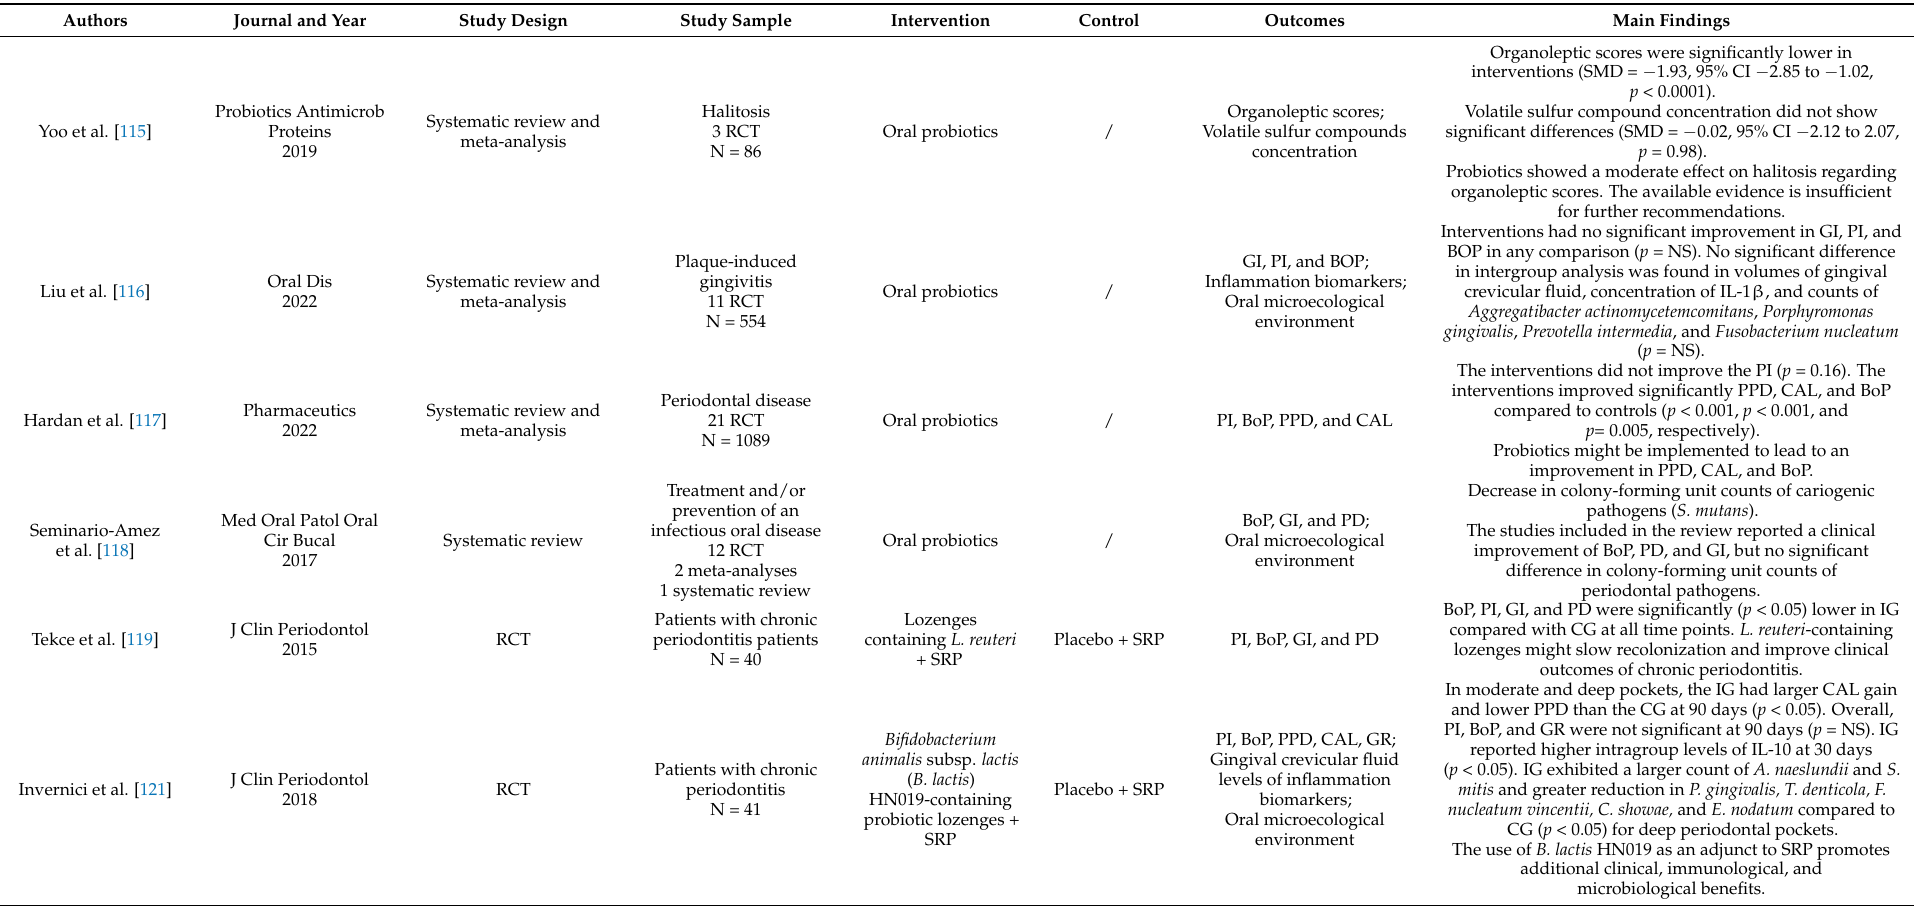
Table 1. Impact of probiotics on the oral microbiota in human